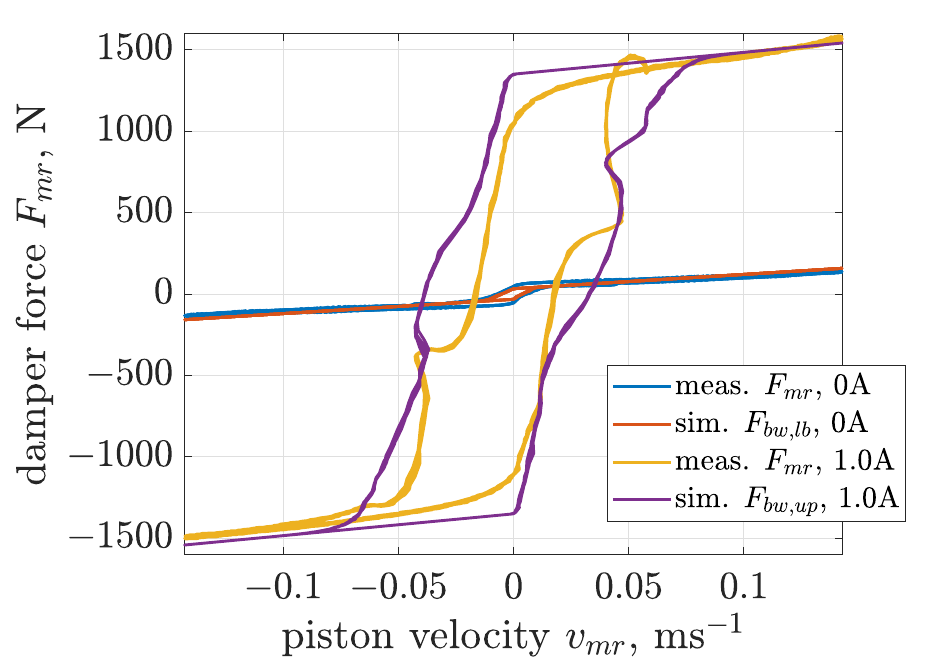
Figure 14. Comparison of force–velocity characteristics obtained for the MR damper and the Bouc–Wen model subjected to the sinusoidal excitation of frequency 1.5 Hz and displacement amplitude 15 mm.